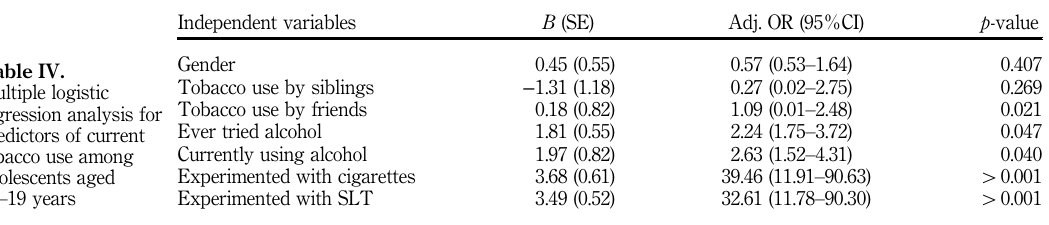
Table IV. Multiple logistic regression analysis for predictors of current tobacco use among adolescents